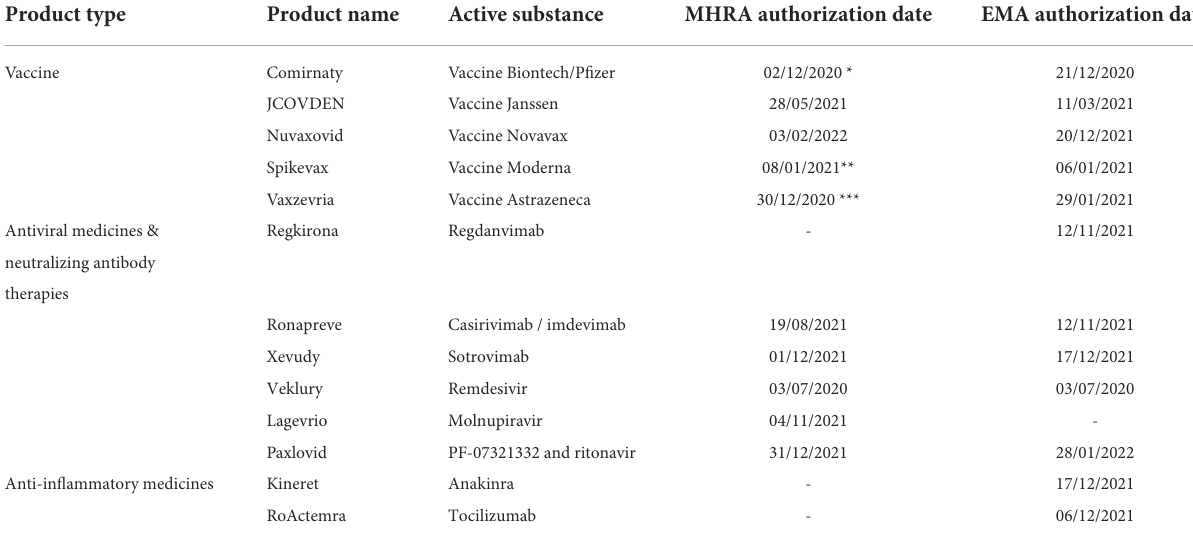
TABLE 3 COVID-19 interventions authorized by MHRA and EMA in